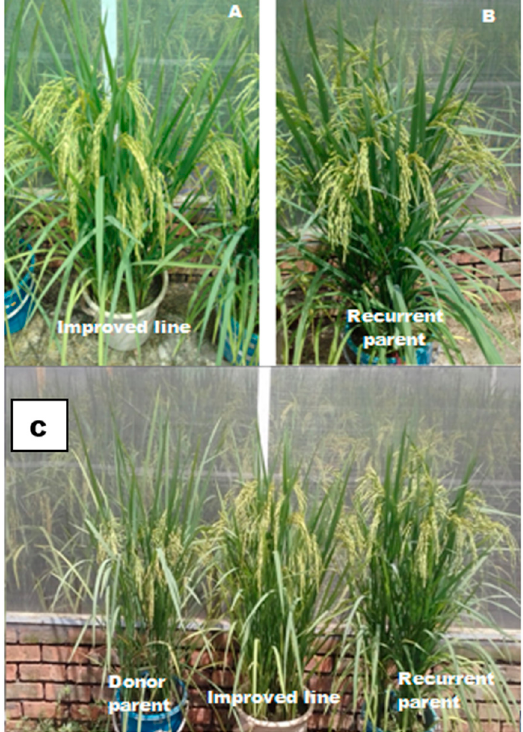
Figure 2. Quantitative traits performance of the newly improved selected lines and their recurrent parent (RP).